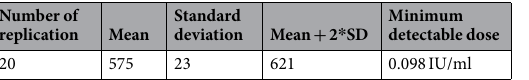
Table 1. Repeated measure of zero standard for assaying the minimum detectable dose.